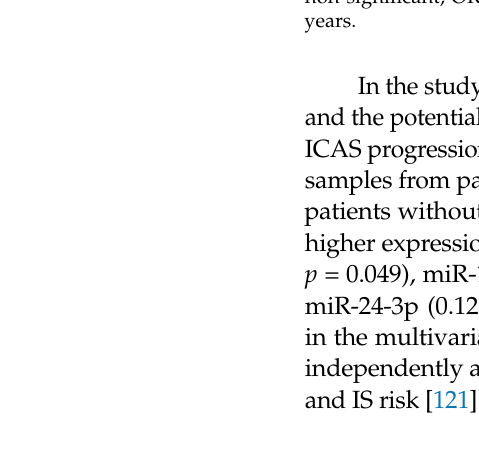
in the multivariate analysis, only the overexpression of a proangiogenic miR-130a-3p was independently associated with the ICAS progression (ORs, 5.4; 95% CI, 1.03–28.2; p = 0.025) and IS risk